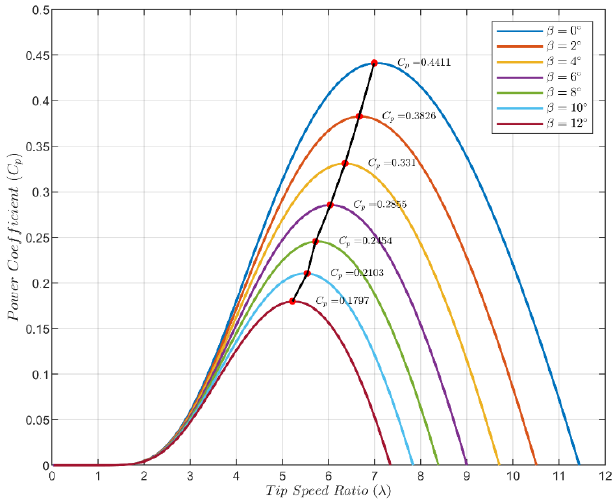
Figure 11. 𝐶 (cid:3043) − 𝜆 (cid:3036) characteristics with variation in pitch angle ( β ). Figure 11. C p − λ i characteristics with variation in pitch angle ( β ). Three case studies are considered to analyze the performance of the proposed Table 6. WECS controller. Different input wind speed profiles are considered for all three cases. Table 7 shows an overview of all three cases of wind speed during the simulation study. Table 7. Input wind speed in all cases.